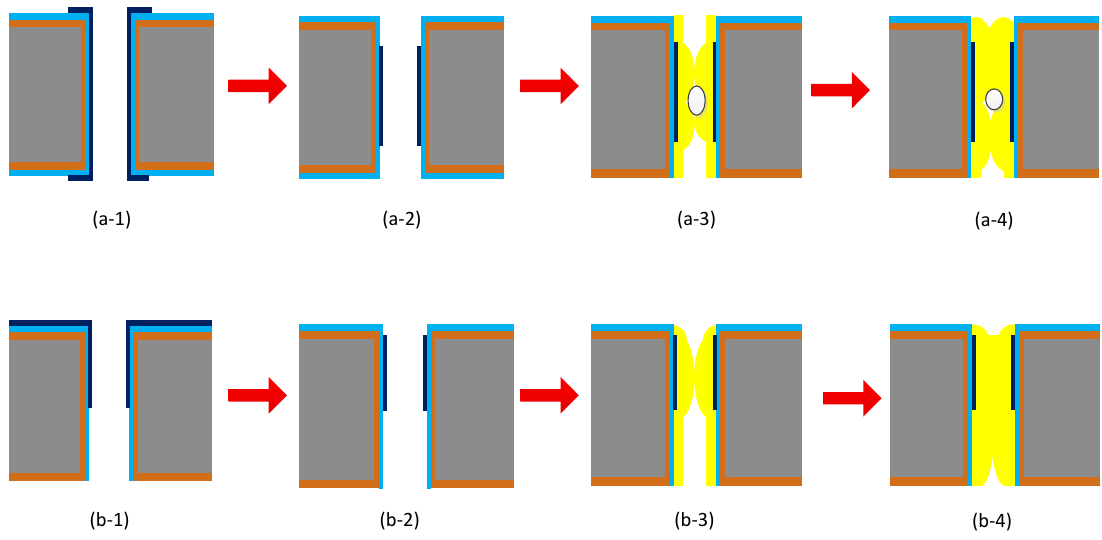
Figure 5. Schematic illustration of the mechanism for Cu growth. ( a ) Double-side sputtering of TSV; ( b ) Single-side sputtering of TSV.